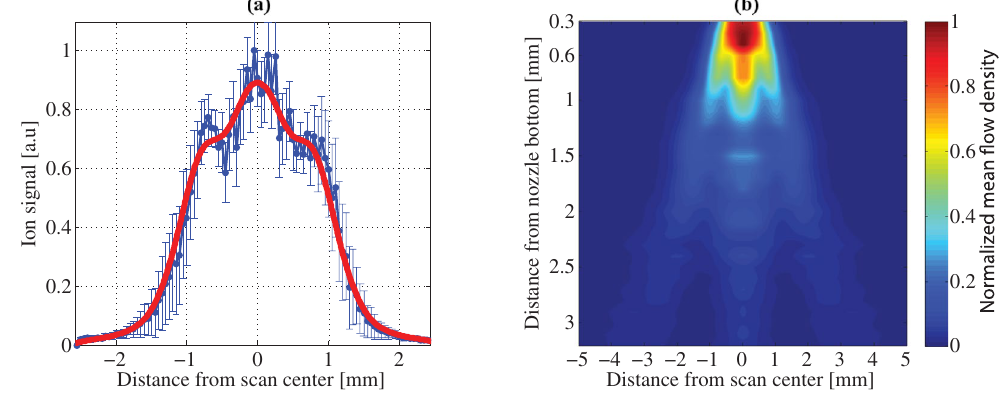
Figure 3. Experimental results: ( a ) Typical measured scan along Y axis (shown for X = 0.9 mm below nozzle). ( b ) Reconstructed normalized mean flow density ( ρ MF ( r )) shown across (XY) plane as defined in Fig.